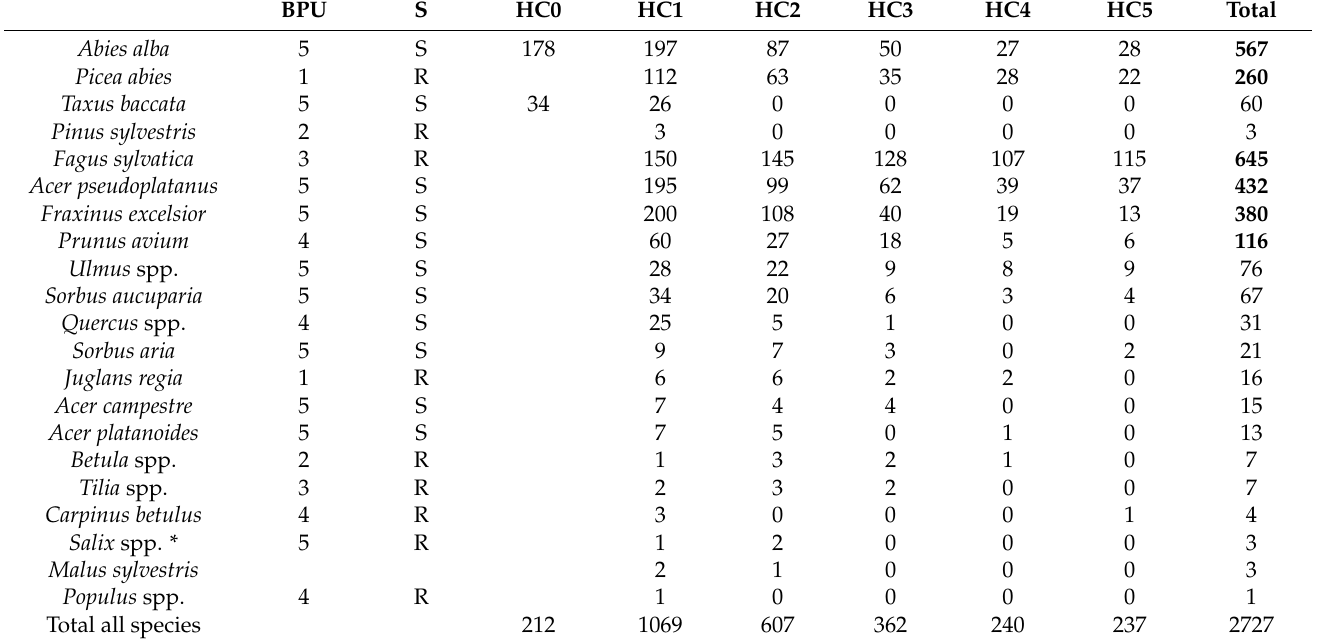
Table 1. Number of saplings observed per tree species and height class (HC). For species with >100 sapling in the HC1 to HC4, total numbers (HC0 to HC5) are printed in bold, these species are also referred to as ‘main species’. Information is given about the browsing preference by ungulate (BPU) class, with 1 = unpalatable and 5 = highly palatable and preferentially browsed, and the species- specific sensitivity to browsing (S) following [50], with S = susceptible and R = resistant. The species are sorted into evergreen and deciduous species in descending order of total